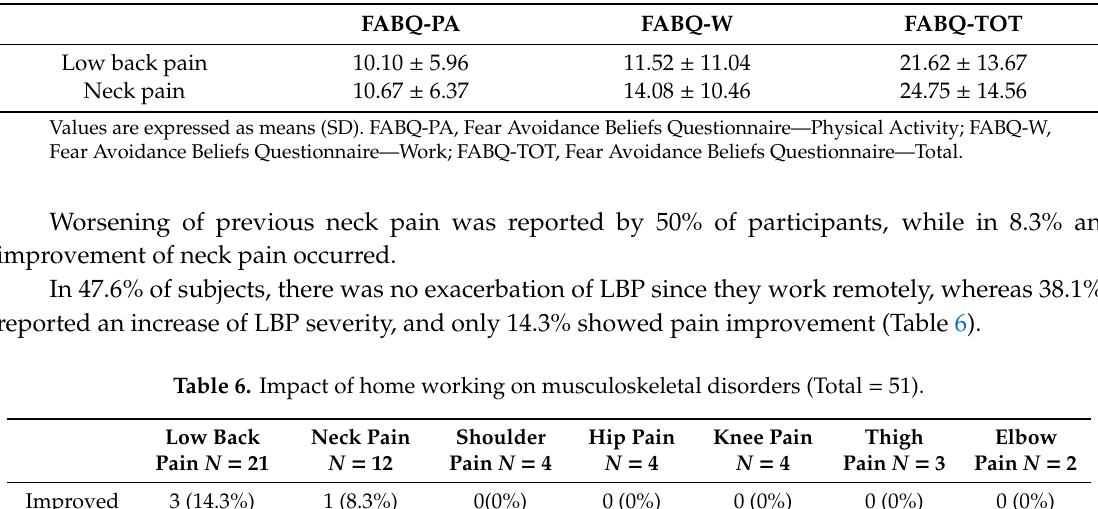
Table 5. Low back and neck pain measured with the Fear Avoidance Beliefs Questionnaire (FABQ).